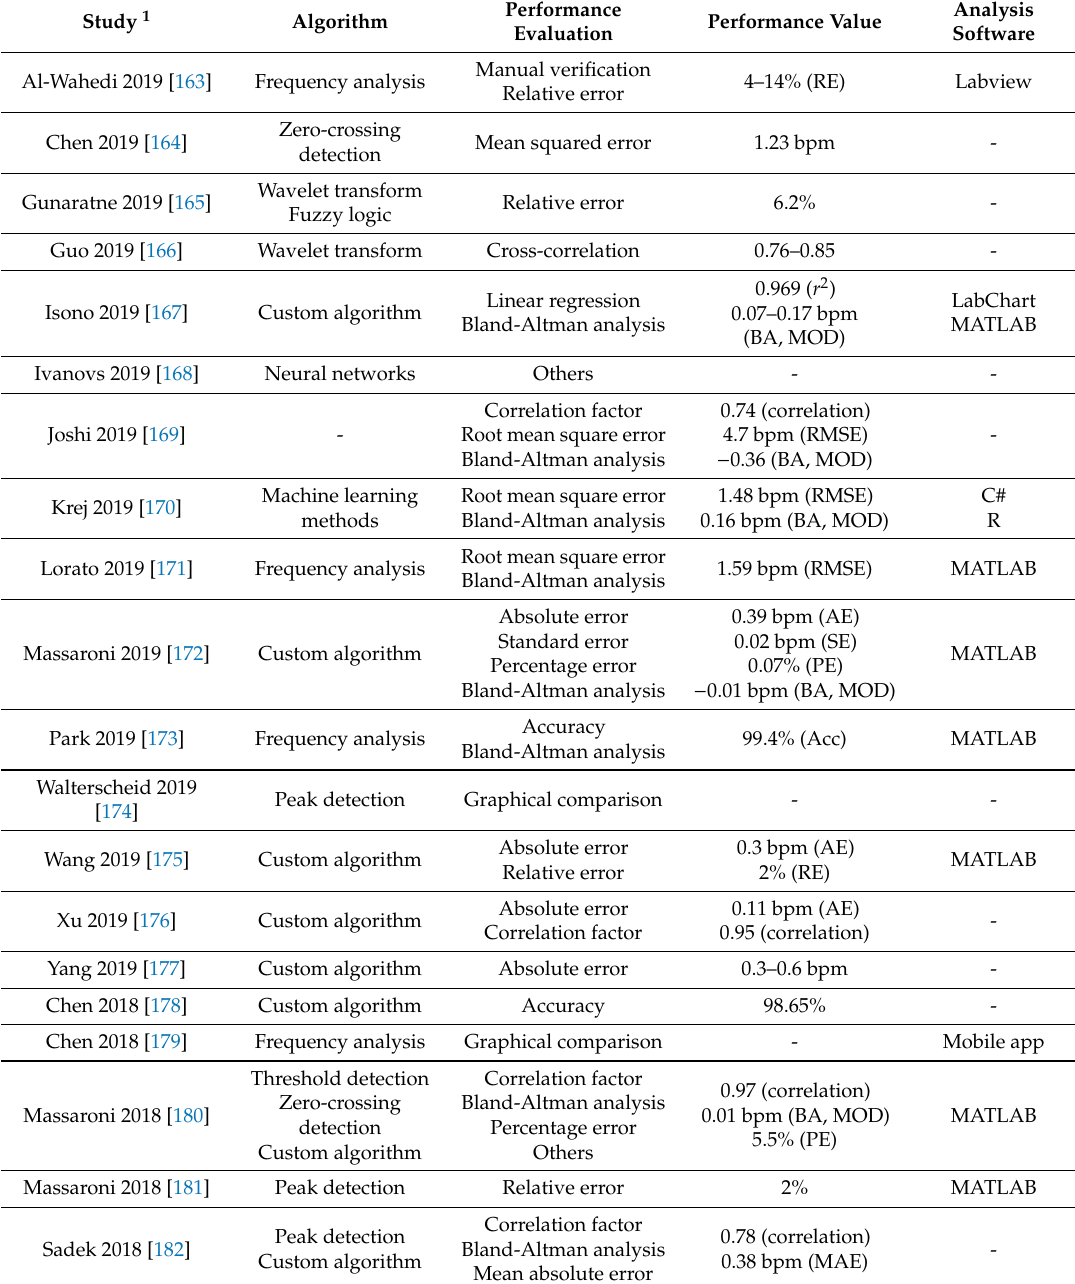
Table 7. Analysis of the processing algorithm, performance evaluation, and software for the studies of the environmental